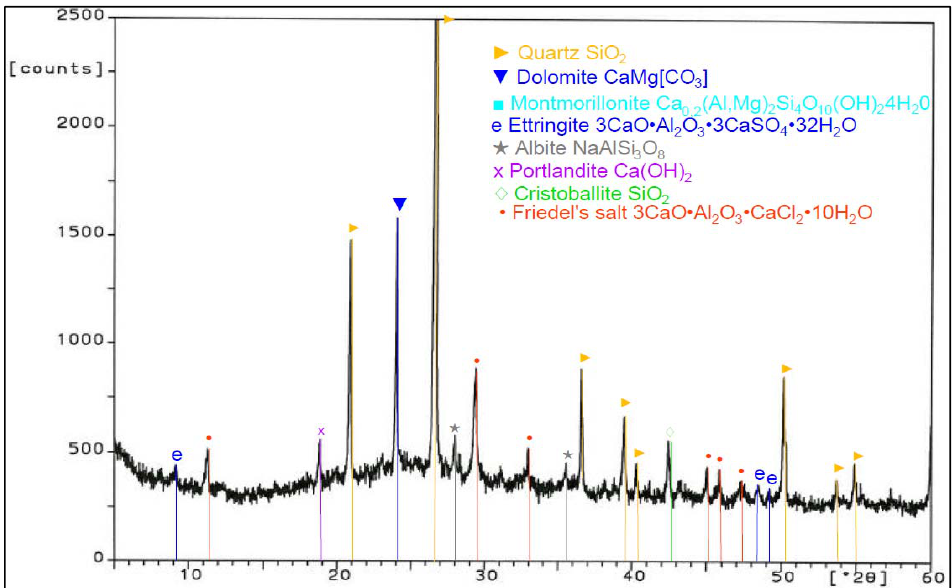
Figure 28. XRD pattern of the ZIV mortar (CEM I + 25% FBC + 20% CFA) stored in 1% HCl for 730 days.